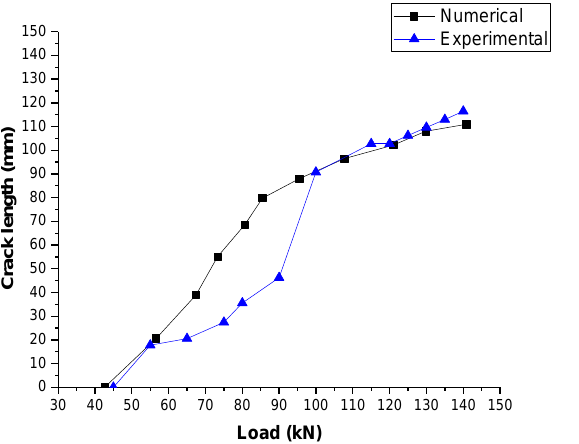
Figure 6. Comparison of the crack propagation in the numerical and experimental results.